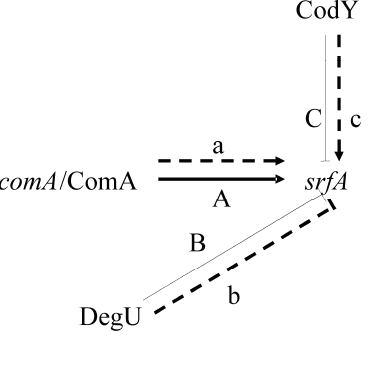
Figure 5. Simplified scheme showing some of the regulators of surfactin synthesis and the roles of ComA, DegU, and CodY in positive ( → ) and negative ( ┤ ) regulation. The solid lines and capital letters show the regulation has been confirmed in the literature, the dash lines and small letters show the regulation speculated in this